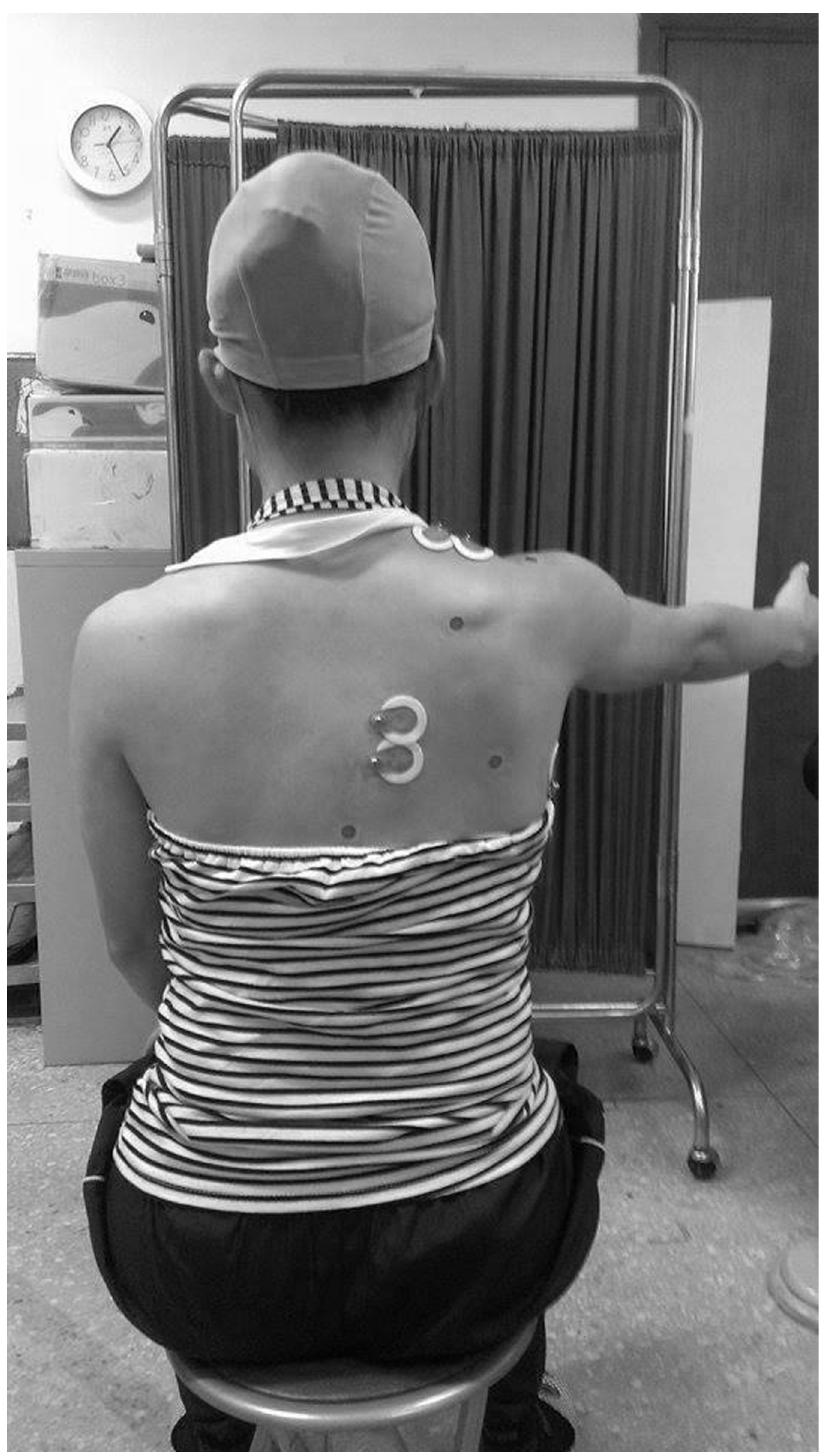
Fig 1. TMS testing position. The participant held the arm at 90-degree scpation elevation during TMS assessment.